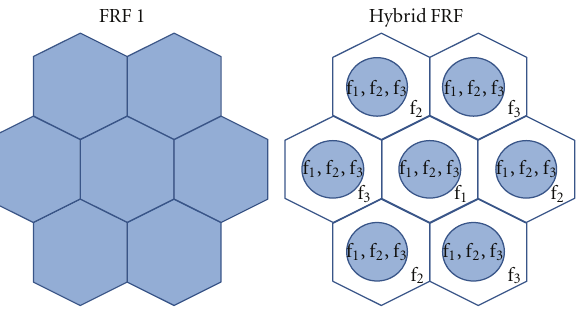
Figure 2: Structure of single FRF and hybrid